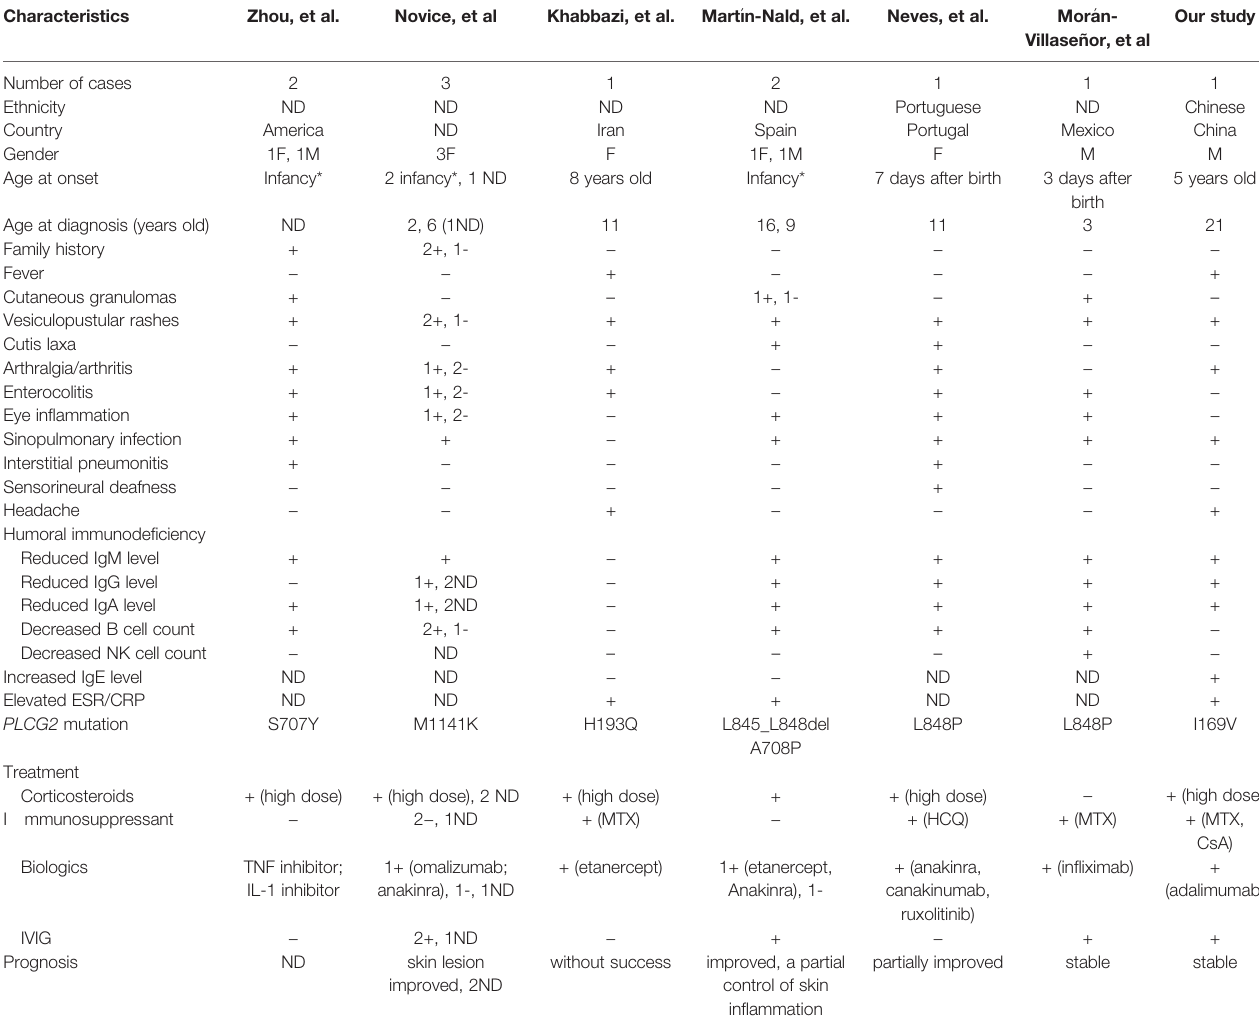
TABLE 1 | Summarization of phenotypic and genotypic features of 11 patients with APLAID.